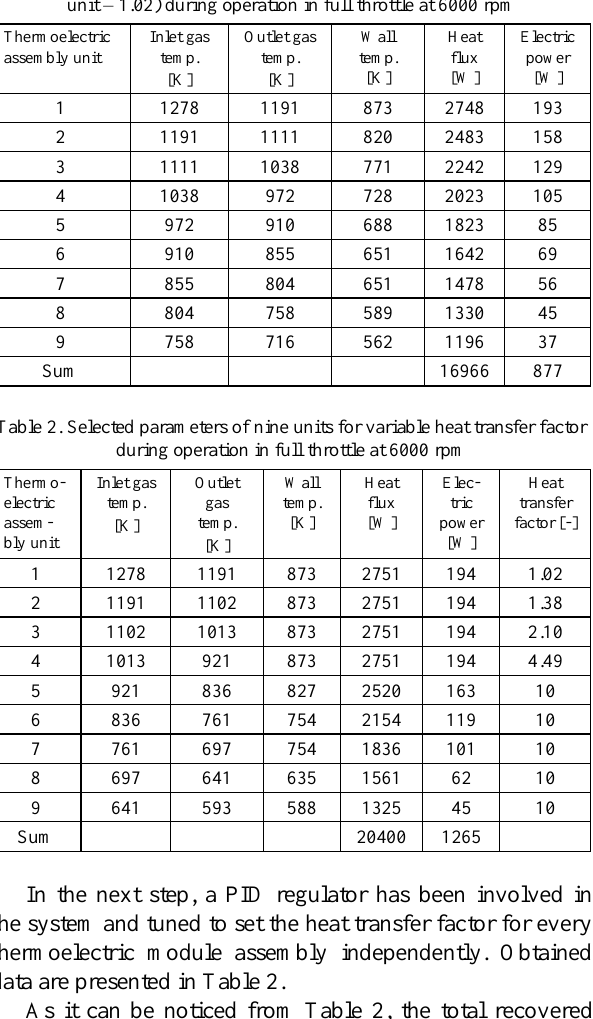
Table 1. Selected parameters of nine units (heat transfer factor for every unit – 1.02) during operation in full throttle at 6000 rpm Thermoelectric assembly unit